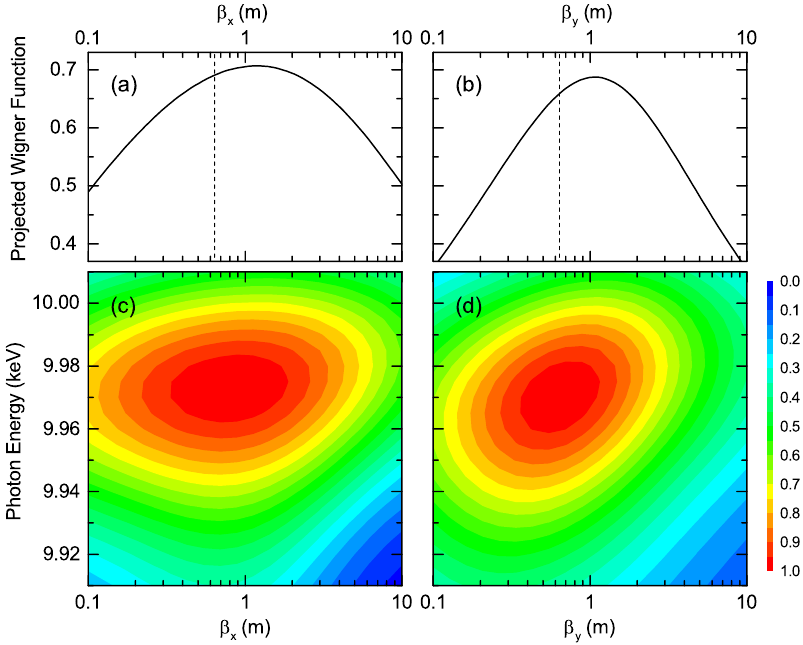
ˆ W 0 ; 0 Þ are computed as a function of the betatron h;v ð